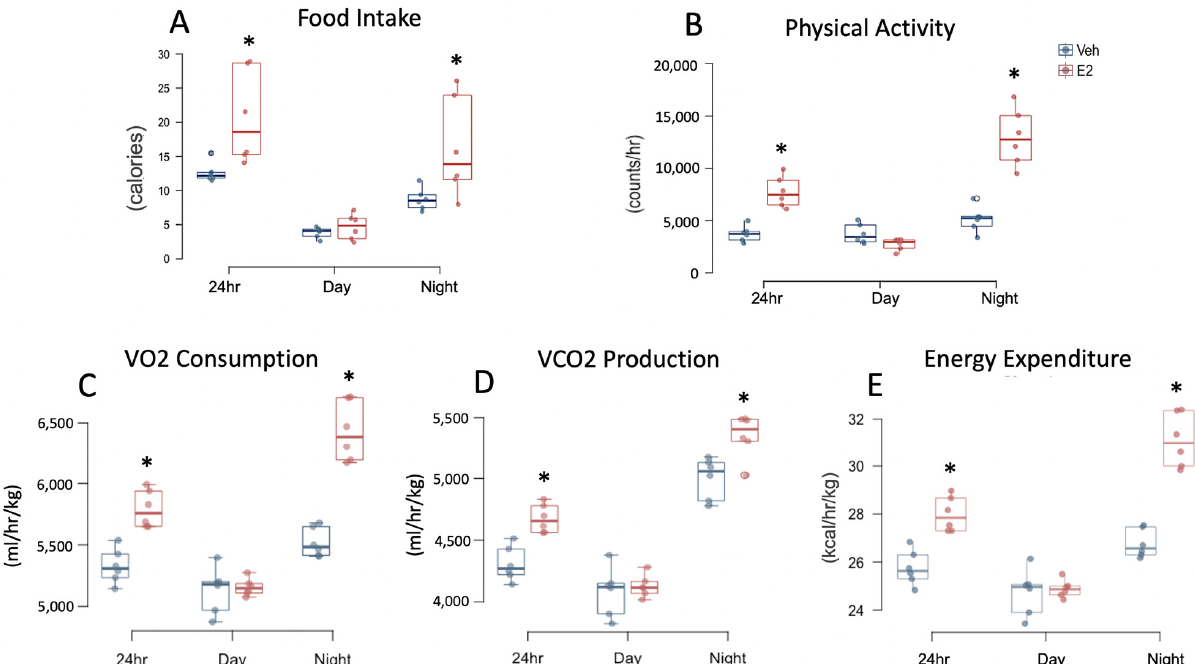
Figure 3. Estradiol increases food intake, water intake, and energy expenditure in female mice fed HFD. Food intake ( A ) Physical activity ( B ) VO2 consumption ( C ) VCO2 production ( D ) Resting energy expenditure ( E ) were measured in mice in metabolic cages on days 15–17 of HFD feeding. The average 24-h data were obtained from 72-h data and used for statistical analysis. * indicates differences between E2 and Veh mice (n = 6/group) ( p < 0.05; t -test).